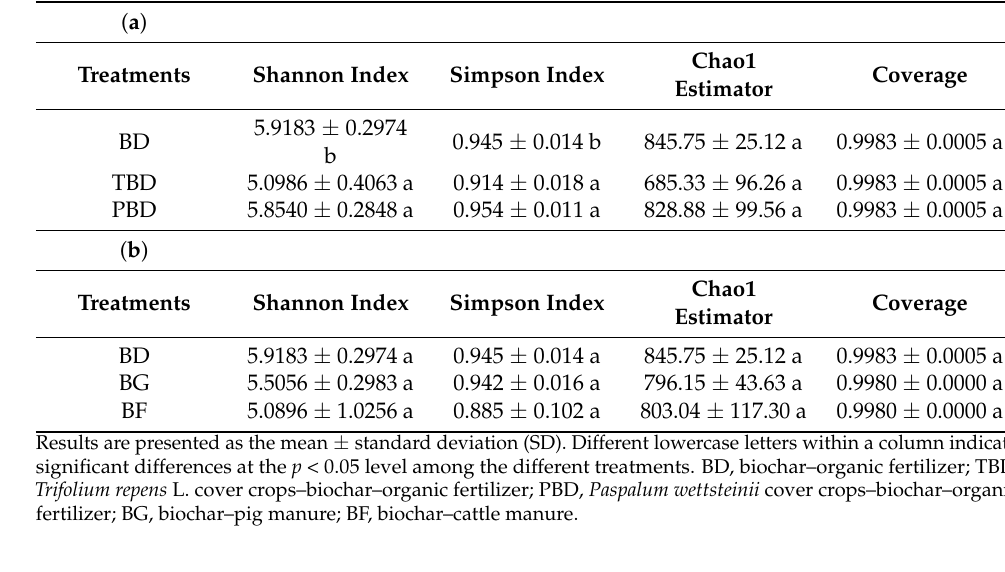
Table 2. Soil fungal diversity (Shannon and Simpson indices), abundance (Chao1 estimator), and coverage under combined remediation treatments. ( a ). Soil fungal diversity, abundance, and cov- erage under different cover crops–biochar–organic fertilizer treatments. ( b ). Soil fungal diversity, abundance, and coverage under different biochar–organic fertilizer treatments.